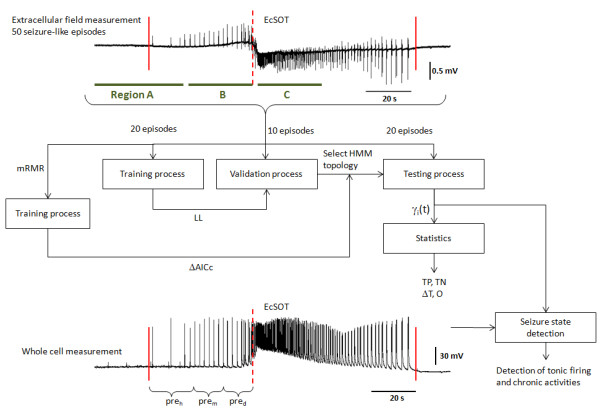
Graphical representation on the method of evaluating HMMs. On the top illustration, the LFP is illustrated. Maximum Lyapunov exponent analysis is used to determine the initiation and termination of seizure activities (marked by solid vertical lines). The seizure detection horizon is defined as a 1 min time window centered on the EcSOT (marked by dotted vertical line) and is denoted by regions B and C. After the initial training process (using 40% of the overall dataset) on the full 7-D and 14-D feature space, the performance of each HMM is evaluated using the validation set (20% of the overall dataset) to determine the HMMopt7D and HMMopt14D topology. Afterwards, feature reduction from mRMR analysis and AICc are used to find a suitable HMMAIC that balance the LL against the number of model parameters. The statistical tests (TP and TN) as well as optimality index (O) are then evaluated. On the bottom illustration, the intracellular activity before the EcSOT is partitioned based on its polarity characteristics into three states: hyperpolarizing (Preh), depolarizing (Pred) and a mixture of hyperpolarizing and depolarizing (Prem) activities [35]. This information is then compared to the γj(t) associated with the tonic firing patterns in the HMM to evaluate the correlation between the multiple model states with the intracellular dynamics.